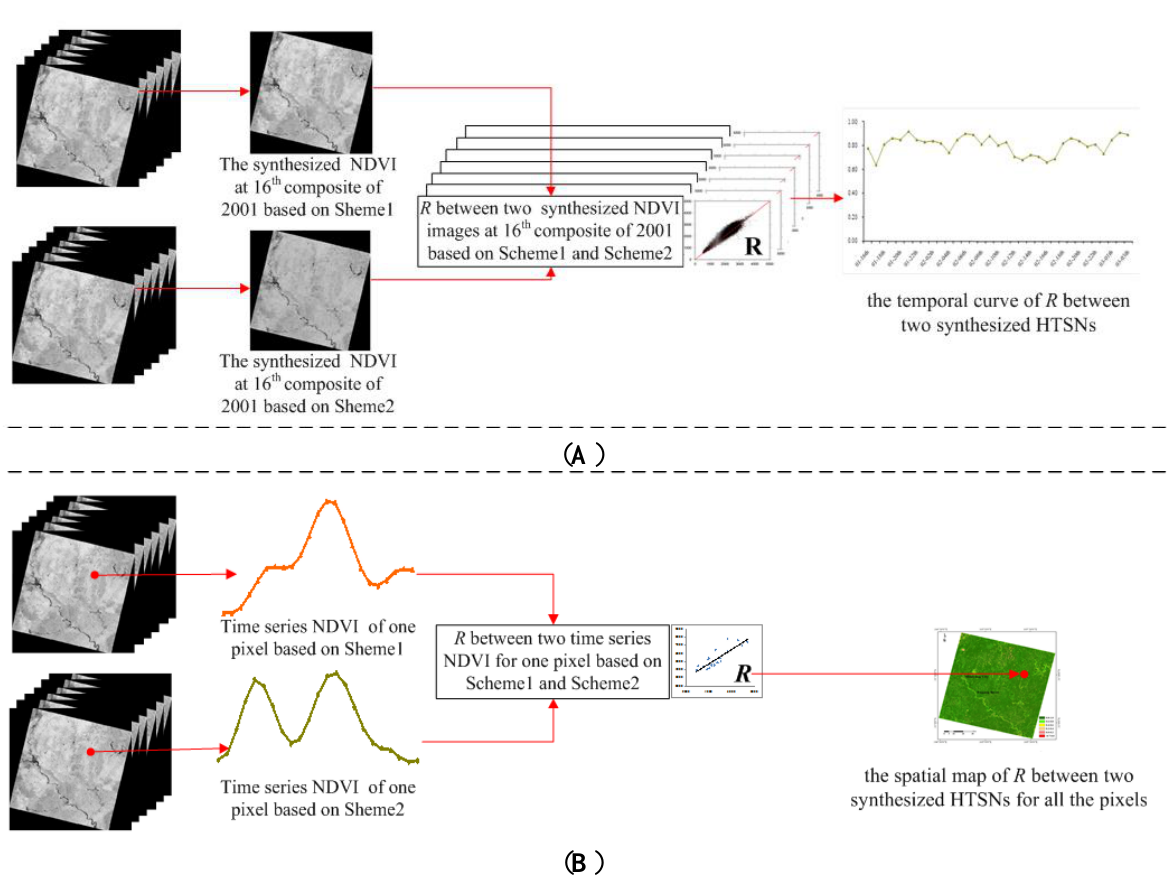
Figure 4. The illustrations for describing the temporal consistence and the spatial consistence between two HTSNs synthesized by two different schemes. ( A ) Temporal correlation: taking the 16th composite in 2001 as an example, the correlation coefficient R between the two synthesized NDVI images at the composite was calculated; the value was a point of the temporal curve of R between the two synthesized HTSNs; ( B ) Spatial correlation: taking one pixel as an example, two time-series NDVI values for the pixel were extracted, and the correlation coefficient R between them was calculated; the value was a point of the spatial map of R between two synthesized HTSNs for all the